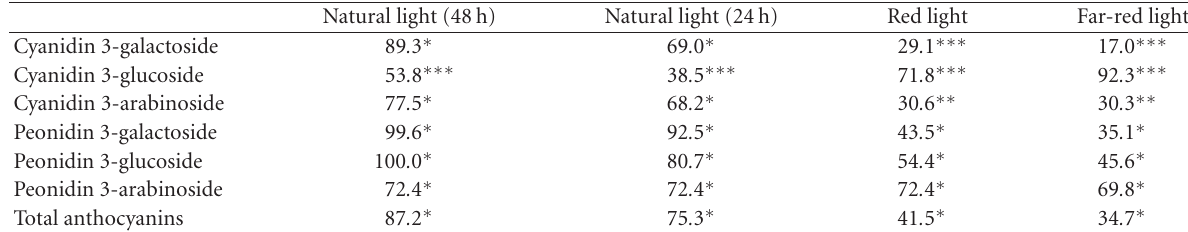
Table 2. Percentage of anthocyanin increased in submerged, harvested cranberries exposed to di ff erent light conditions in comparison with the control, which was kept in the dark. Natural light (48 h) Natural light (24h) Red light Far-red light Cyanidin 3-galactoside 89 . 3 ∗ Cyanidin